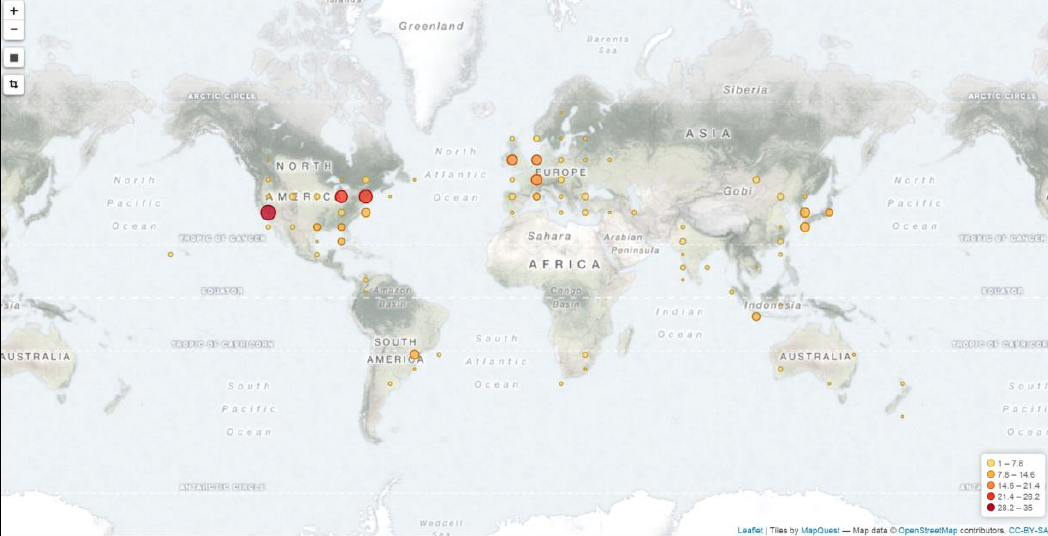
Figure 7. Heat Map of where users come from.